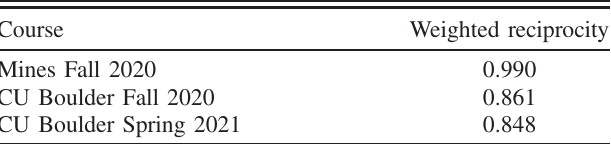
TABLE III. The reciprocity for each of the courses in the present study. The reciprocity takes on values from 0 (for no reciprocity) to 1 (completely reciprocal). The method proposed by Squartini et al. was used to calculated the reciprocity taking edge weight into account